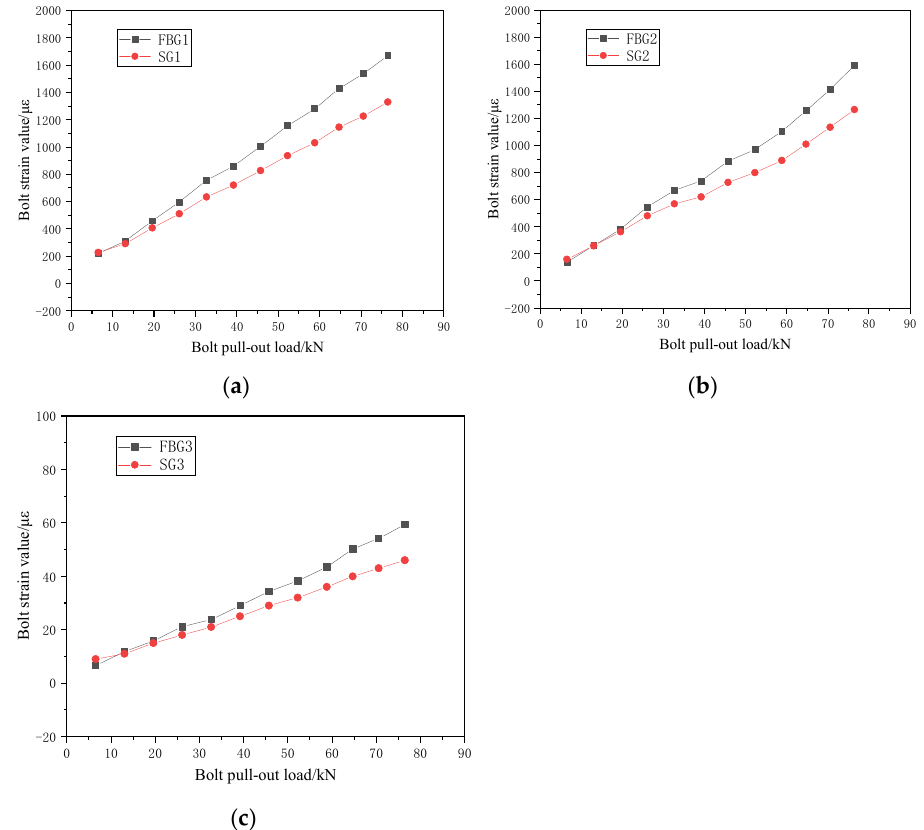
Figure 9. Comparison of test results between FBG sensor and SG for ( a ) FBG1, ( b ) FBG2, and ( c ) FBG3.